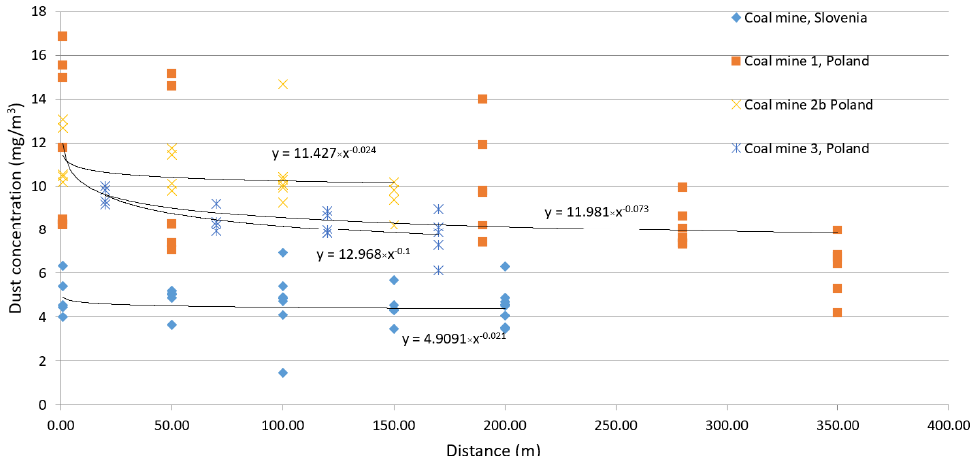
Figure 7. Characteristics of the average distribution of PM4 dust concentration in gates depending on distance from a source of dust, based on dust concentration measurements using the CIP10R with the functions describing them.